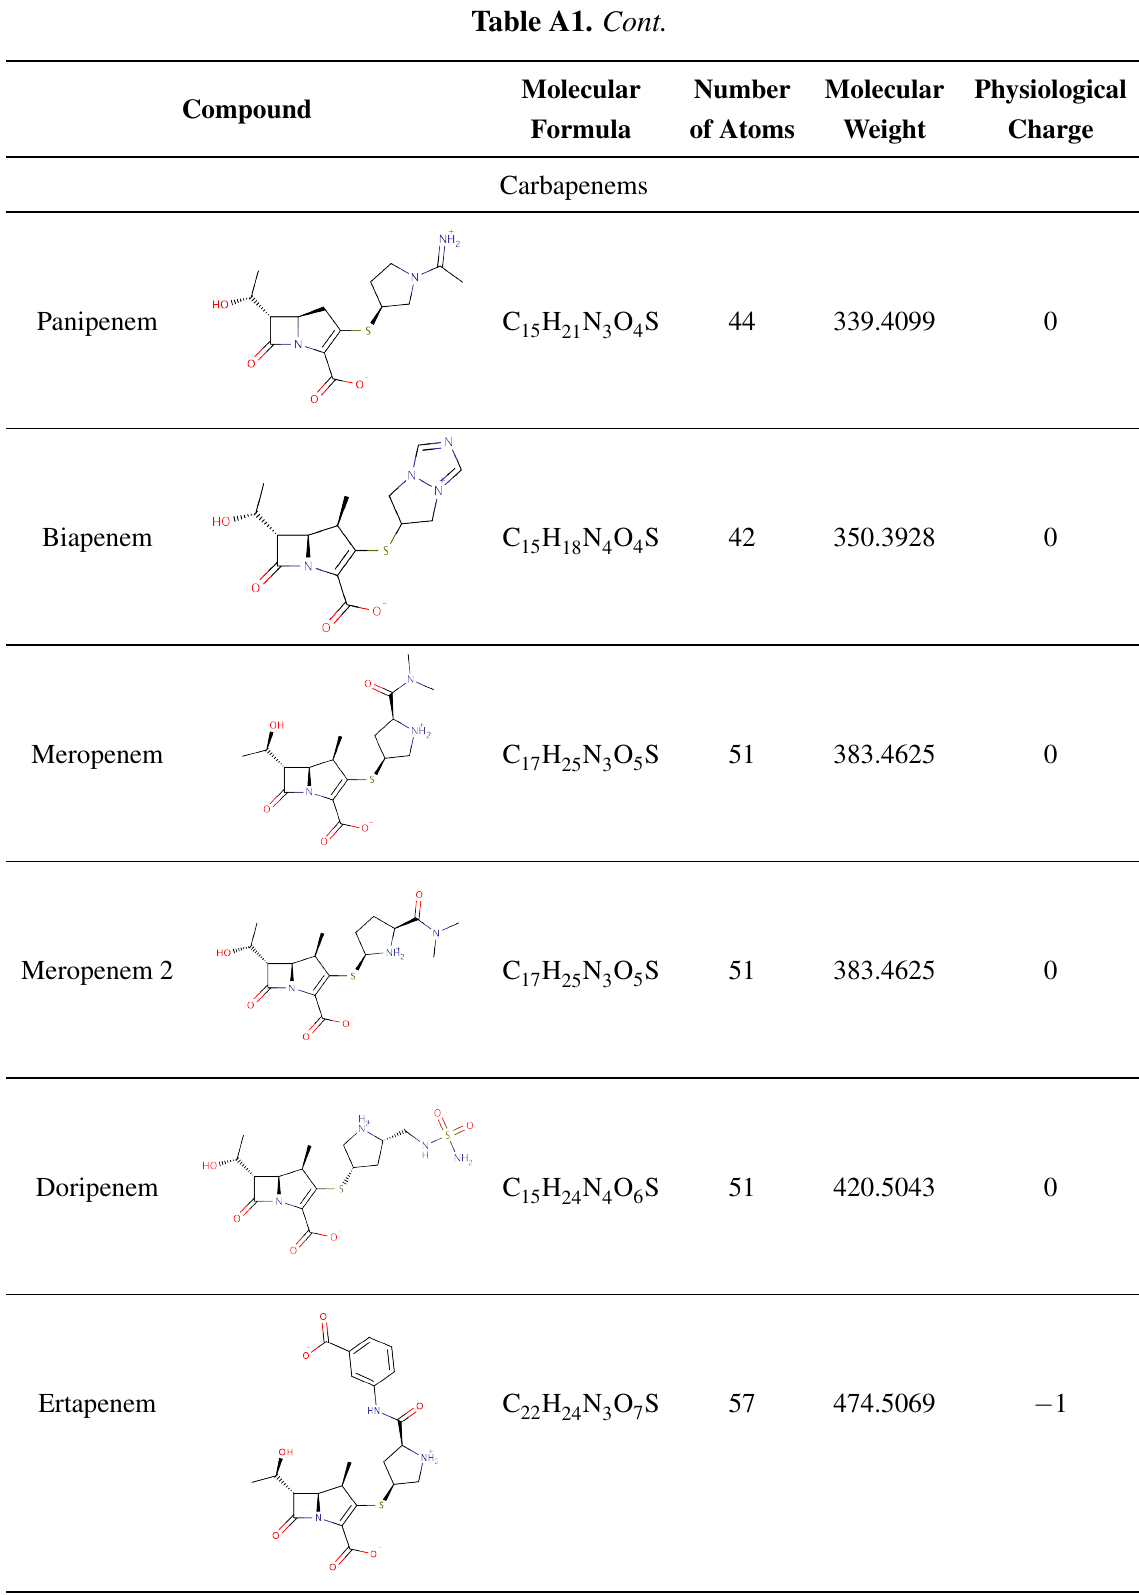
Table A1. Cont. Molecular Number Molecular Physiological Compound Formula of